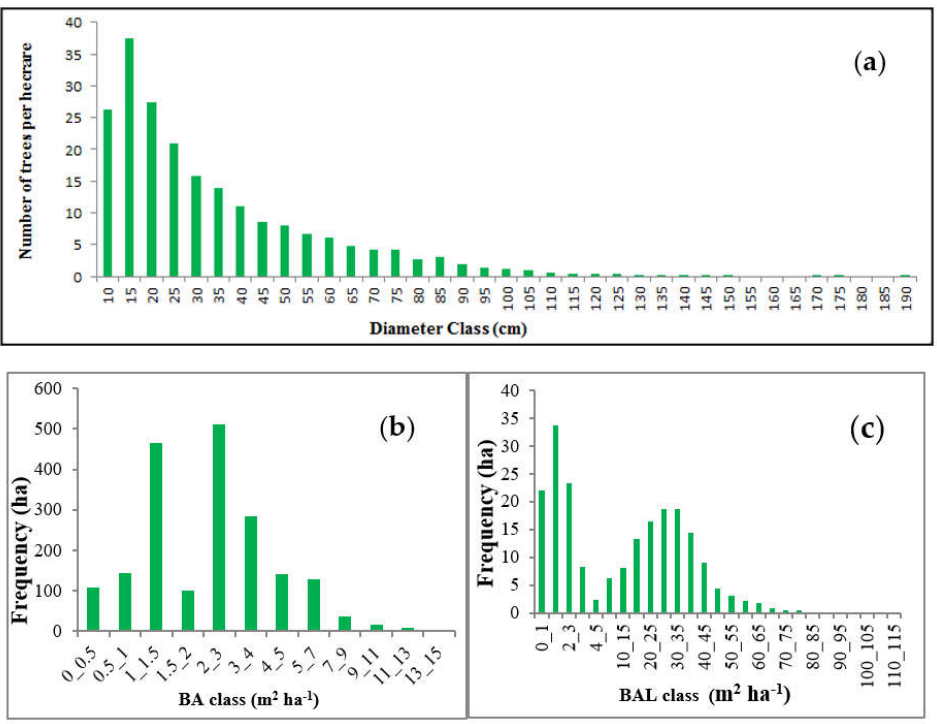
Figure 3. Class frequency of the biotic factors (DBH ( a ), BA ( b ), and BAL ( c )). DBH is diameter at breast height (cm), BA is basal area (m 2 ha −1 ), and BAL is basal area in largest trees (m2 ha −1 ).